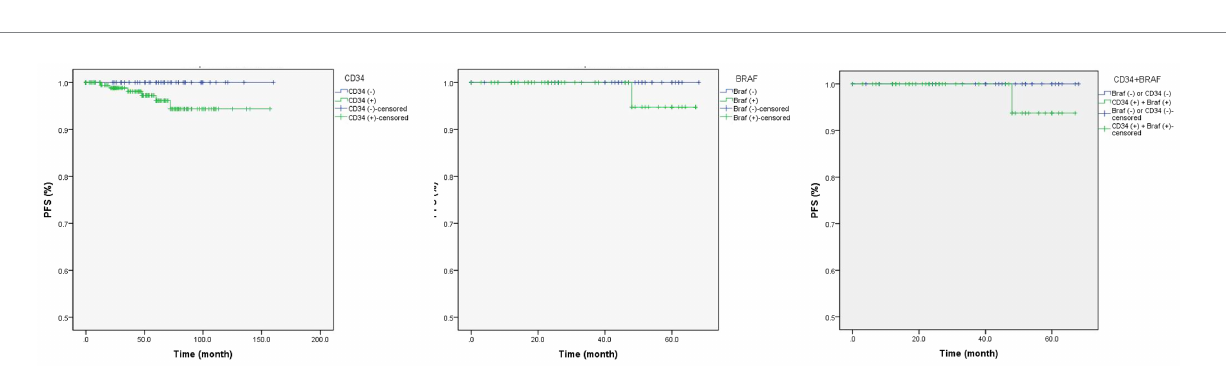
FIGURE 2 The Kaplan Meier curves of CD34 expression and/or BRAF V600E mutation in gangliogliomas with epilepsy. CD34 expression (left; Log Rank test: χ 2 = 0.832, p = 0.362) or BRAF V600E mutation (middle; Log Rank test: χ 2 = 0.824, p = 0.364) in gangliogliomas, or both (right; Log Rank test: χ 2 = 0.938, p = 0.333), were not associated with tumor